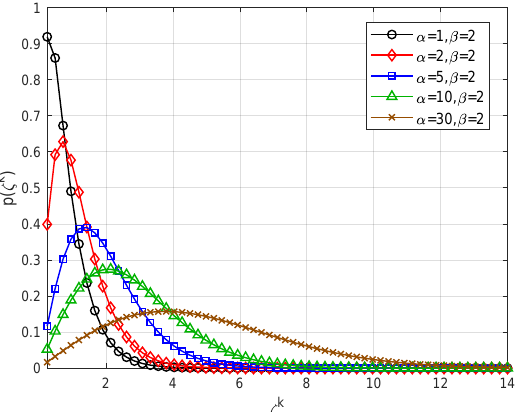
Figure 7. Probability density functions of K-distribution with different shape and scale parameters.